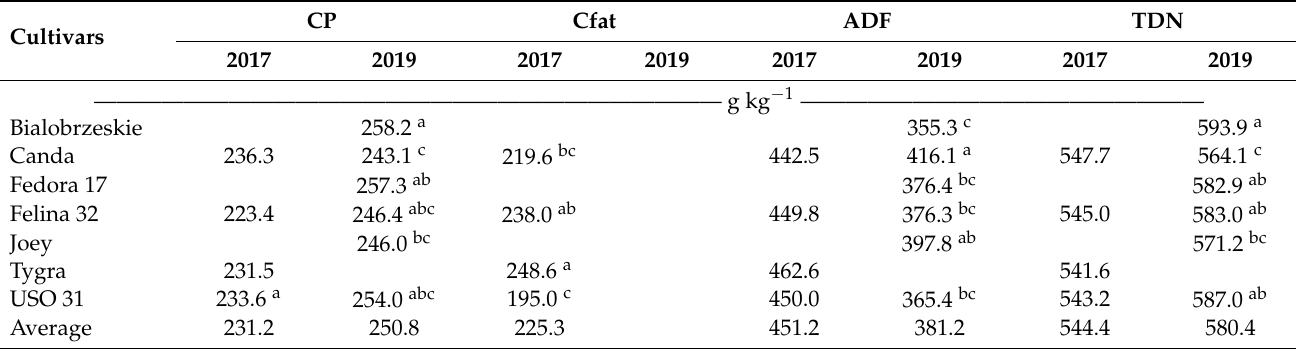
Table 7. Comparison of nutrition quality characteristics (Crude Protein (CP); Crude Fat (Cfat); Acid Detergent Fiber (ADF); and Total Digestible Nutrient (TDN)) of hemp grain. Values are calculated means of different planting dates. CP Cfat Cultivars